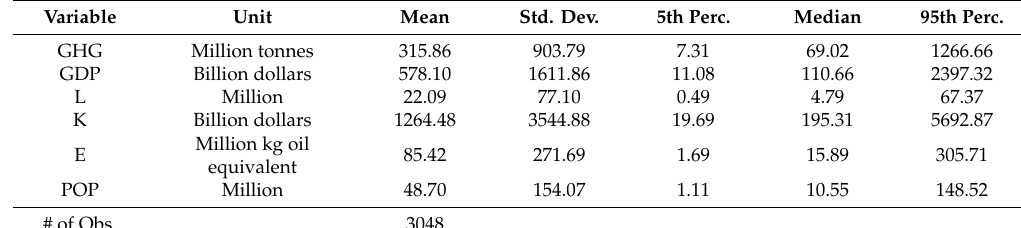
Table 1. Descriptive